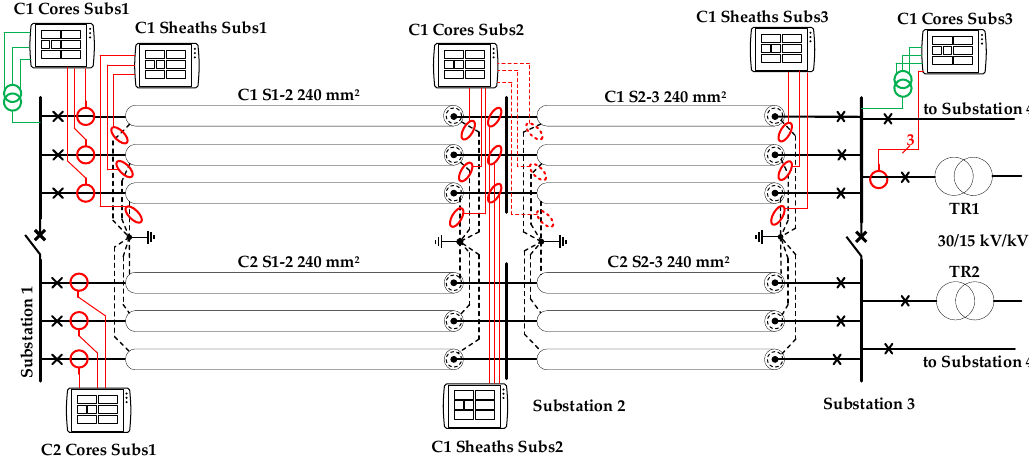
Figure 4. Location of measuring devices; C1 Cores Subs1—currents measurement in cores in Circuit 1 in Substation 1; C1 Sheats Subs1—currents measurement in sheaths in Circuit 1 in Substation 1, etc. The measurement of currents flowing in the sheaths was done using measuring clamps mounted directly on the sheaths. In Substation 1, currents flowing in cores were measured using existing current transformers of the analyzed cable line. In turn, currents flowing in cores in Substation 3 were measured by existing current transformers of TR1 / TR2 30 / 15 kV / kV transformers. The cable lines